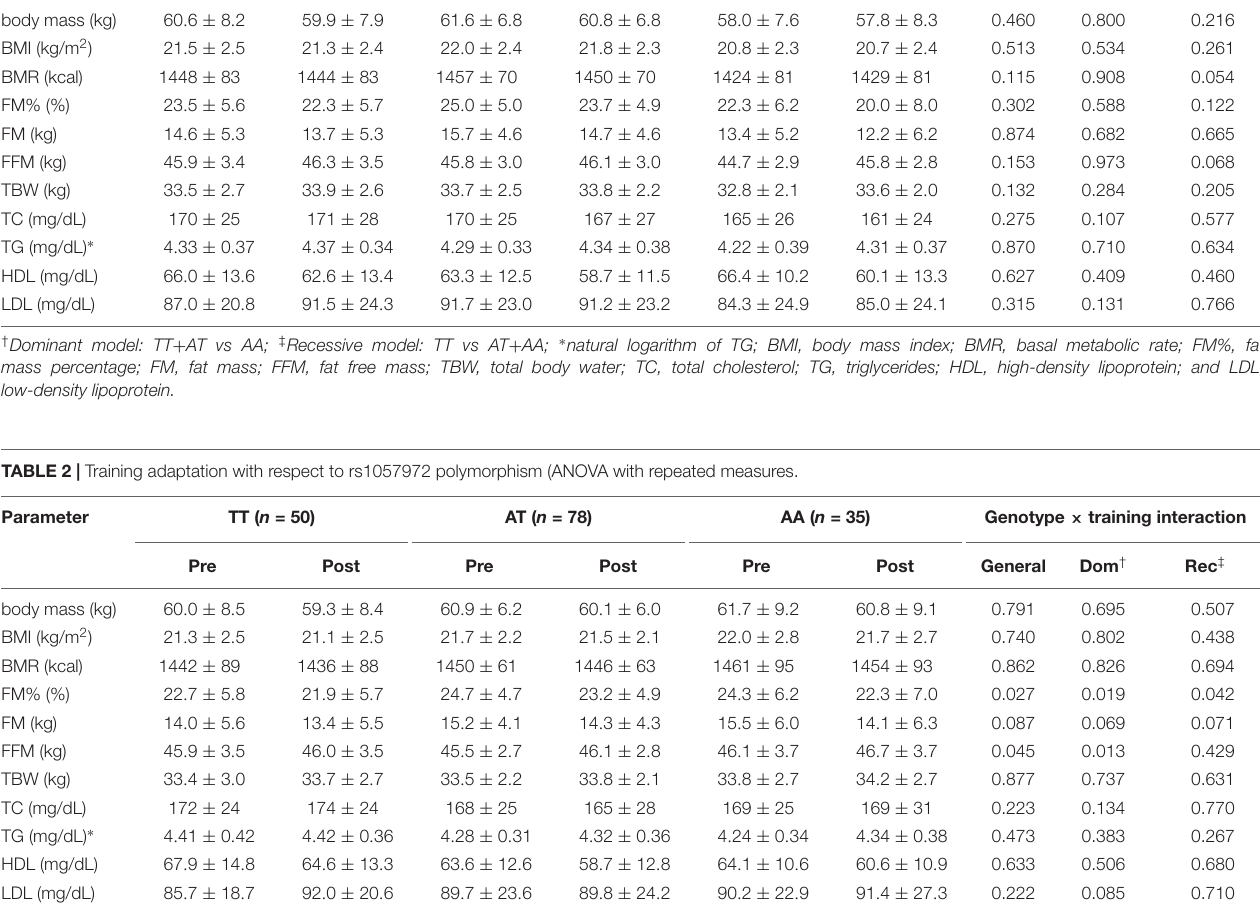
TABLE 1 | Training adaptation with respect to rs1589241 polymorphism (ANOVA with repeated measures). Parameter AA ( n = 88) AT ( n = 62) TT ( n = 13) Genotype × training interaction Pre Post Pre